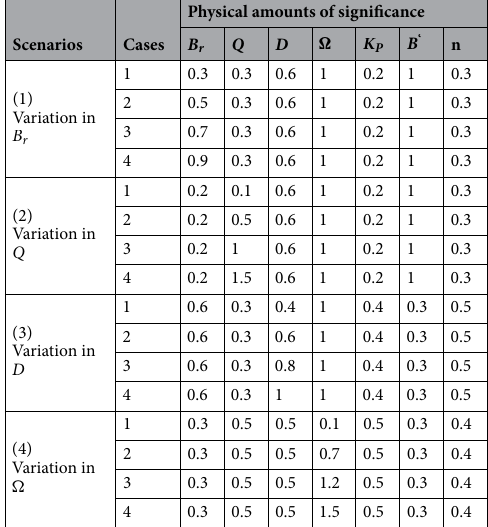
Table 2. Variants of WCS-EPF for Vogel’s model.